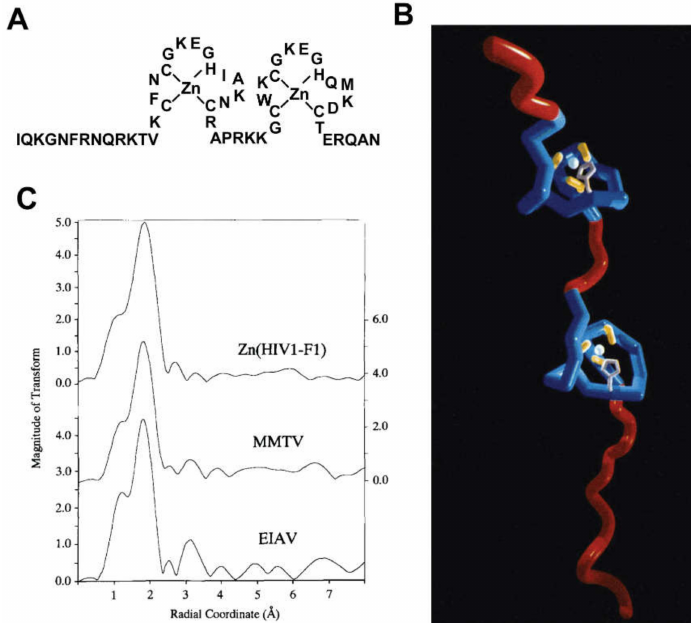
Figure 2. HIV-1 NC is a zinc metalloprotein. ( A ) Amino acid sequence and zinc binding mode of the HIV-1 NL4-3 NC protein. ( B ) NMR structure of HIV-1 NL4-3 NC. The independently folded CCHC “zinc knuckle” domains behave like “beads on a string.” ( C ) Similarities of zinc-edge EXAFS spectra obtained for an isolated HIV-1 CCHC peptide (top) and for intact retroviruses [Mouse Mammary Tumor Virus (center) and Equine Infectious Anemia Virus (bottom)]. Panels ( B , C ) reproduced from [87], with